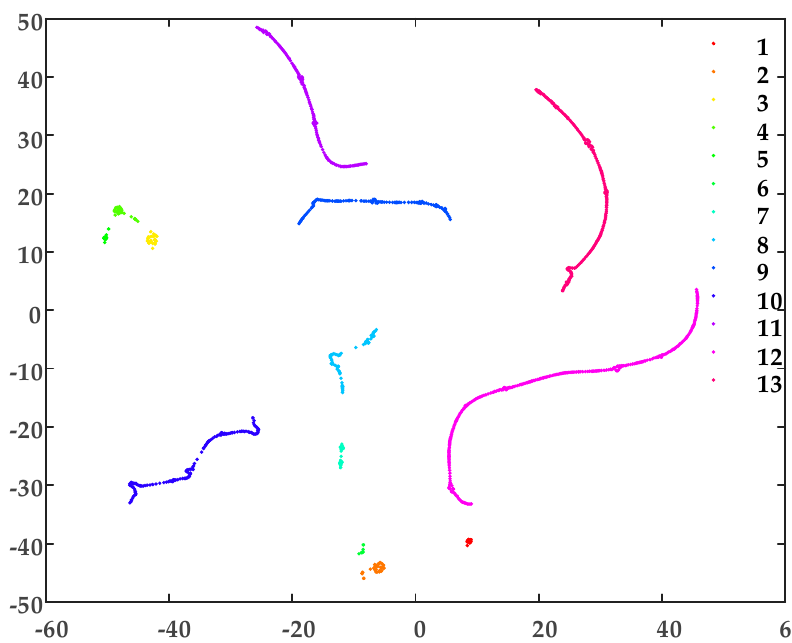
Figure 15. The DBSCAN clustering results for the cross-bonded cable sheath current matrix.